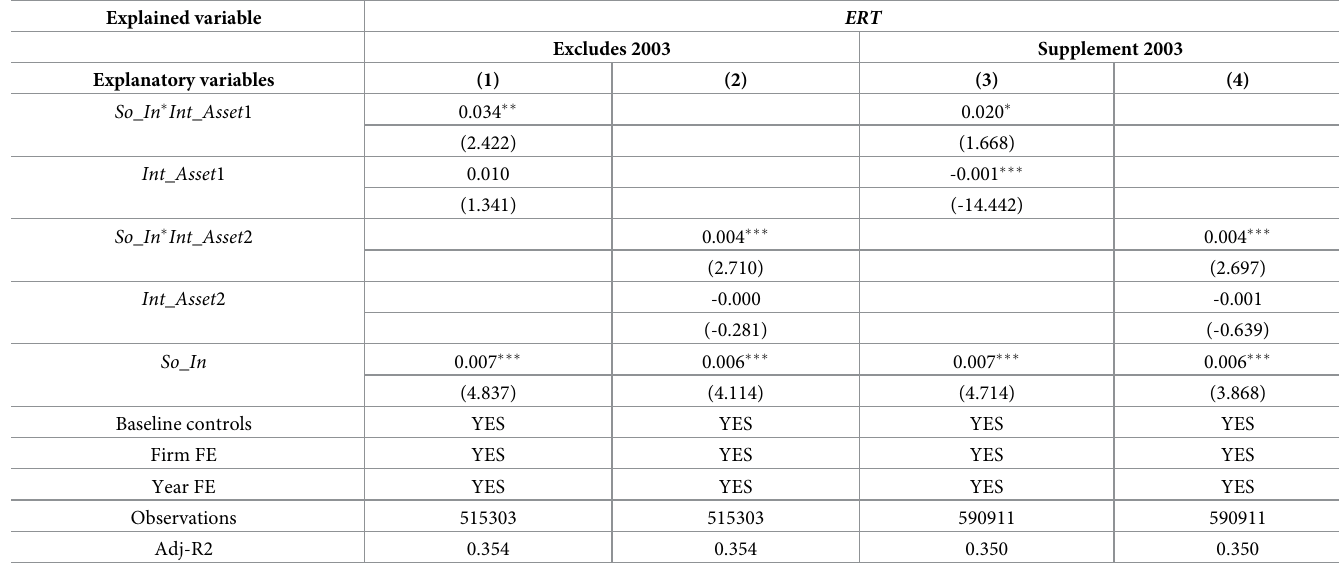
Table 8. Mechanism